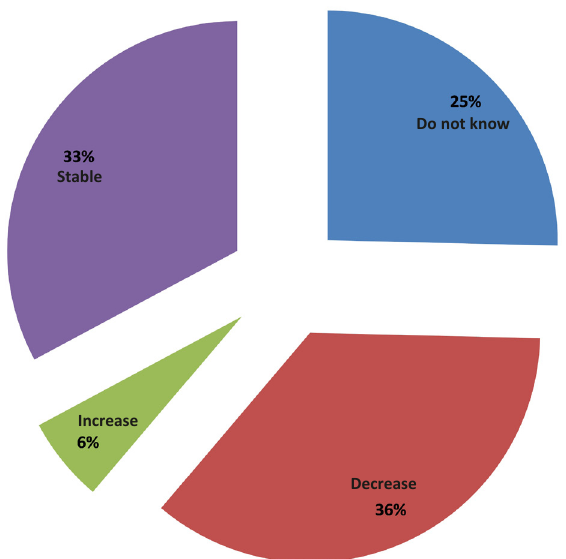
Figure 2. Perception of local riparian community towards the trend of biodiversity in the area